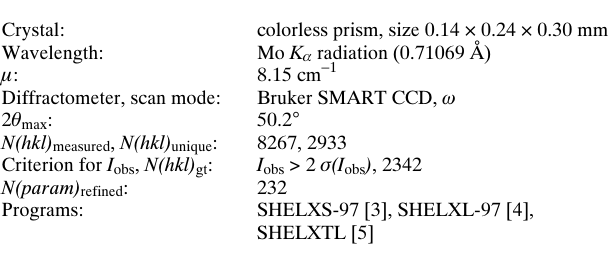
Table 1. Data collection and